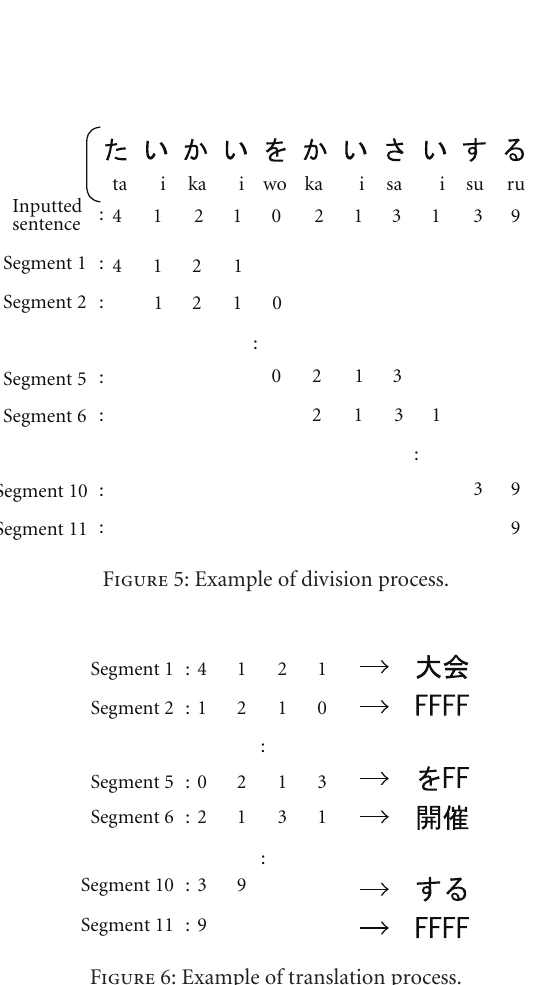
Figure 6: Example of translation